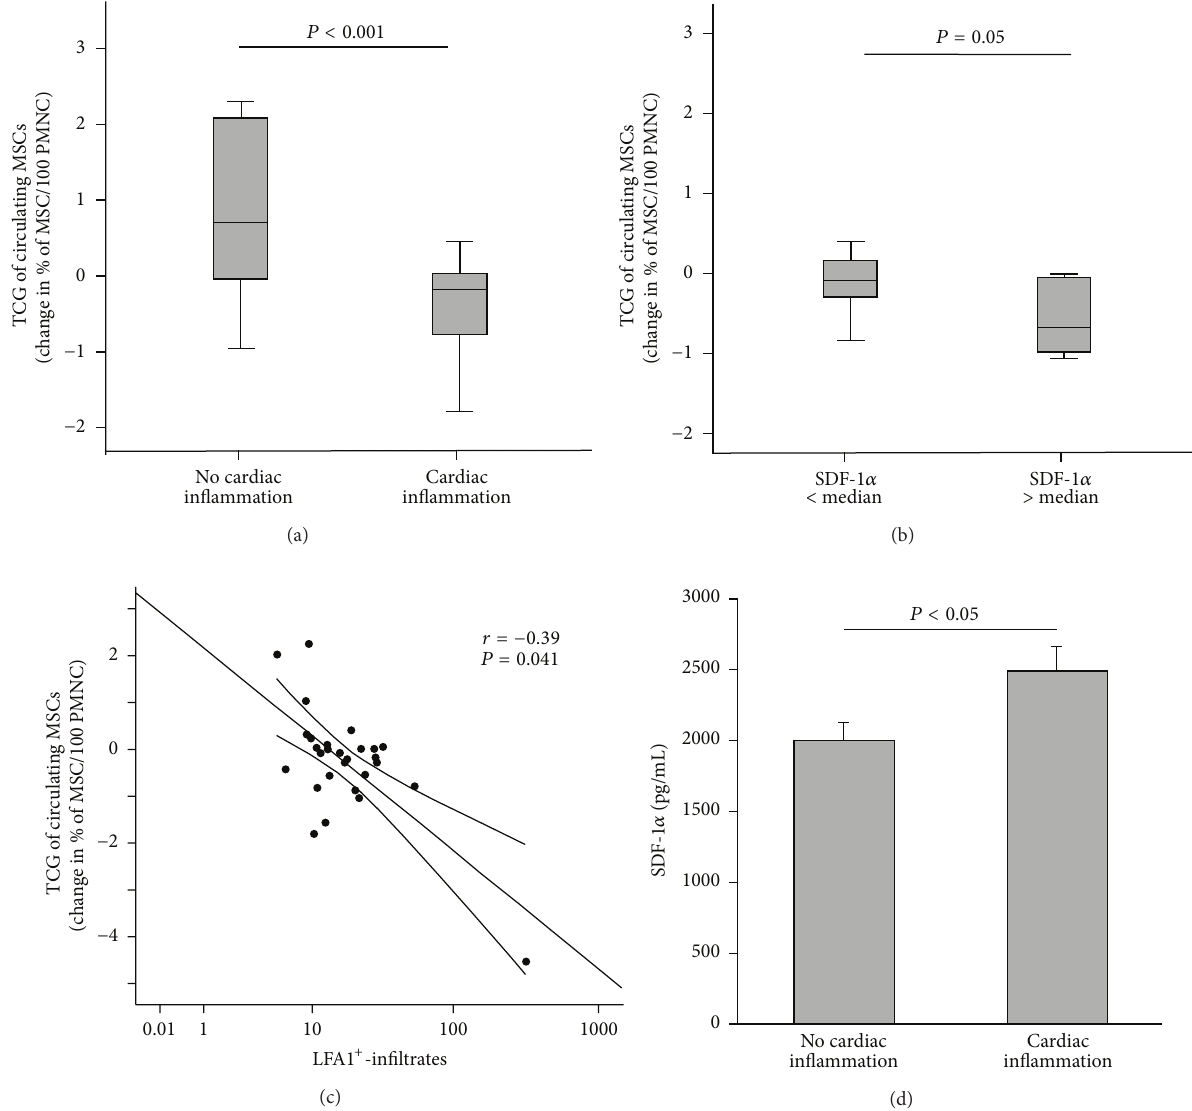
Figure 2: Transcardiac gradients of circulating MSC and Stromal derived factor-1 𝛼 (SDF-1 𝛼 ) related to cardiac inflammation and expression of SDF-1 mRNA. (a) Quantitative analysis of transcardiac gradients of MSC in patients without ( 𝑛 = 6 ) and with ( 𝑛 = 23 ) cardiac inflammation, as defined by the number of LFA-positive cells, is given as median and IQR; whiskers represent 95% CI. (b) Transcardiac gradient of MSC after dichotomisation with respect to SDF-1 𝛼 mRNA in their EMB (cut-off: median, box plots are given as median and IQR; whiskers represent 95% CI). (c) Correlation between transcardiac gradients of MSC and cardiac inflammation. (d) Postcoronary SDF-1 𝛼 levels (pg/mL) in patients without and with cardiac inflammation; bar graphs represent the mean ±